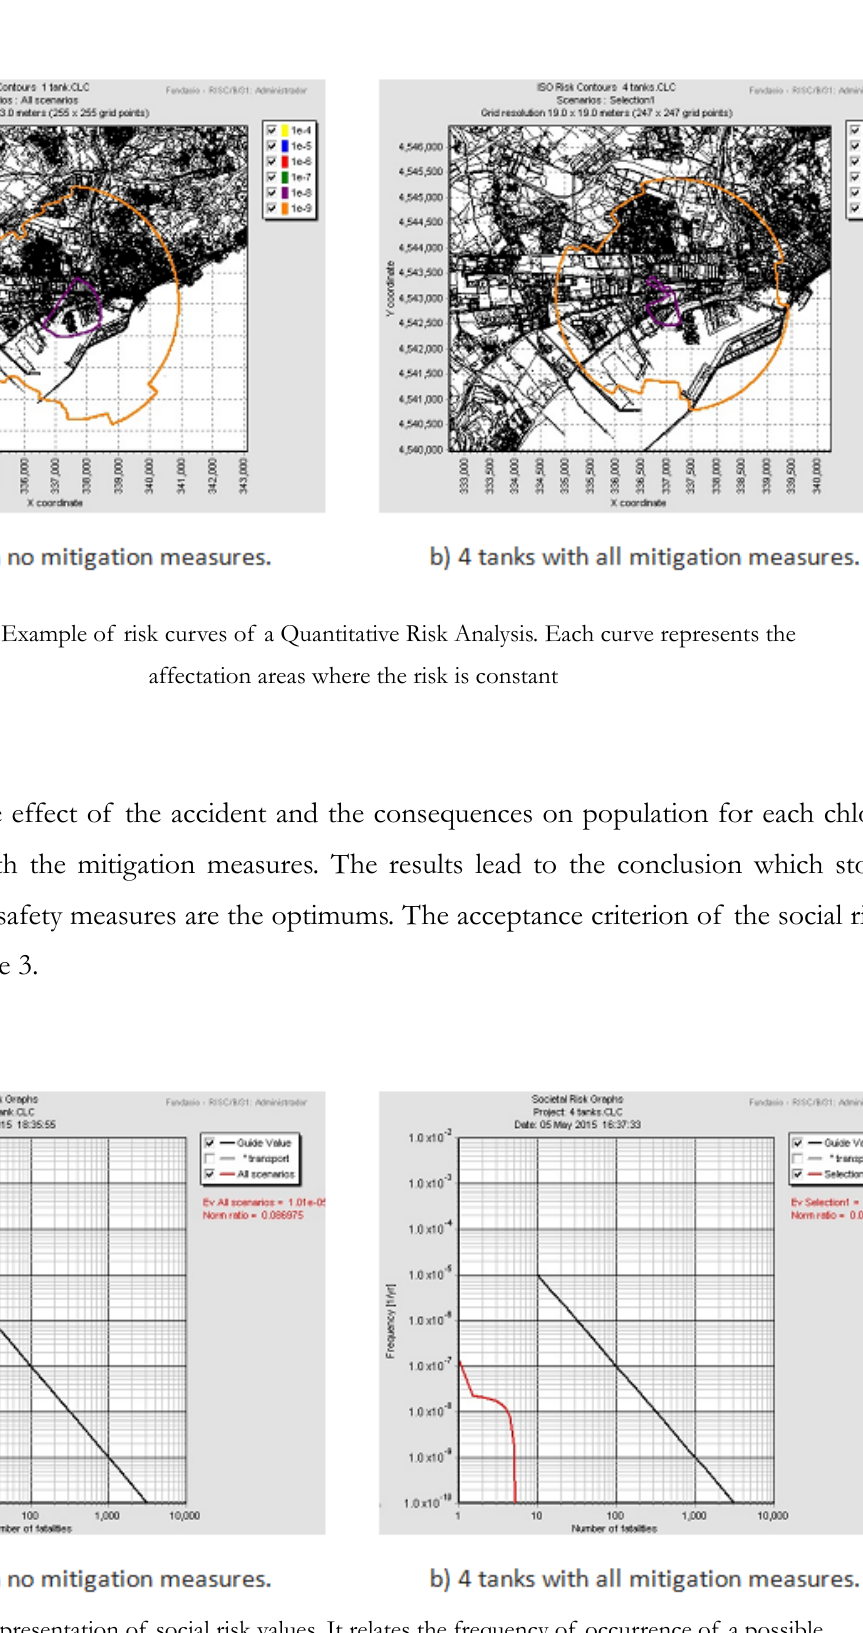
Figure 3. Representation of social risk values. It relates the frequency of occurrence of a possible crash with the mortality associated. If the curve is located below the straight line, the risk is acceptable. Left: no mitigation measures, right: bund and water